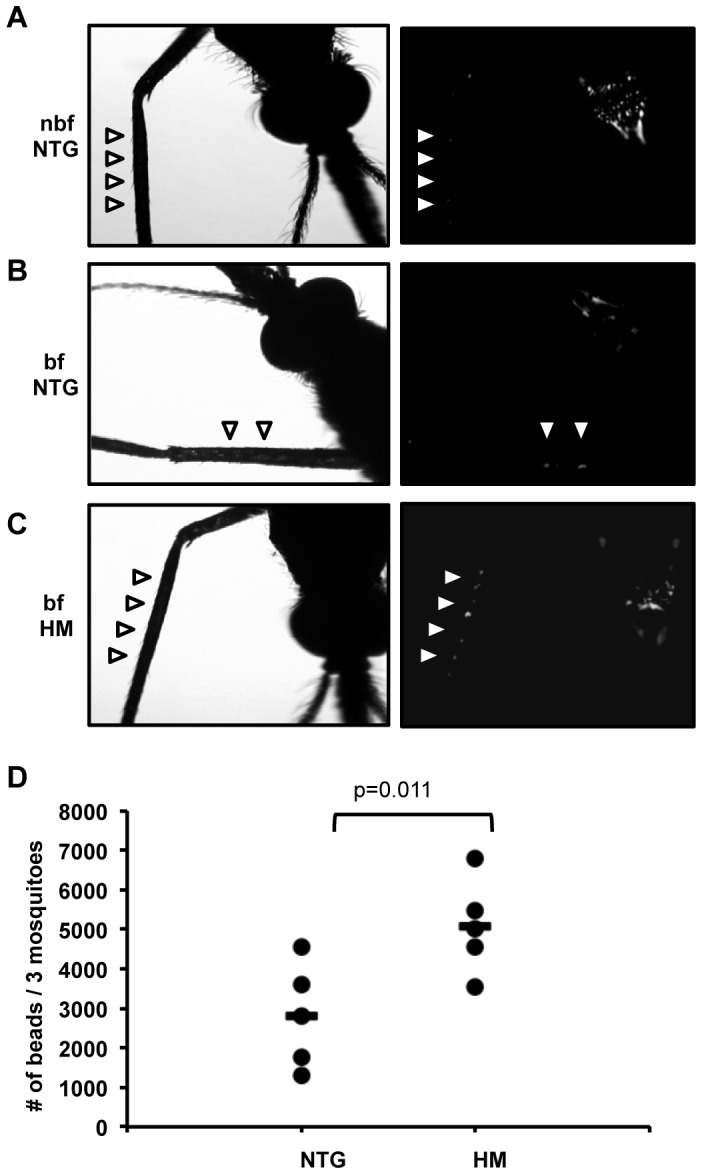
Evaluation of midgut permeability in HM myrAkt relative to NTG An. stephensi.(A) 3–5 d old, age-matched non-blood-fed NTG (nbf NTG), (B) blood-fed (bf) NTG and (C) HM female mosquitoes, were fed fluorescent beads (3–3.5 µM, Spherotech) in a reconstituted human blood meal through a Hemotek Insect Feeding System (Discovery Workshops). Prior to feeding (nbf NTG) and at 48 h post-blood feeding (bf NTG, bf HM), five whole mosquitoes from each group were cold-anesthetized and placed in 24-well plates. Mosquitoes were photographed under normal light (left panels) and also imaged on a Nikon TE 200 inverted fluorescent microscope at 4× with identical settings for all fluorescent images (right panels). Autofluorescence is visible on the mosquito thorax in all images. Arrowheads in nbf NTG mark location of mosquito leg and in bf NTG and bf HM images mark fluorescent beads in mosquito legs, an indication of bead passage through the midgut epithelium into the hemocoel. Note larger number of beads in bf HM compared to bf NTG An. stephensi. (D) Bead numbers per three whole mosquitoes minus bead numbers in three paired midguts from the same groups at 48 h post-feeding are represented as individual dots (means indicated as bars). Midgut beads averaged 236 for bf NTG and 225 for bf HM at 48 h post-feeding, so midgut beads accounted for less than 10% and less than 5%, respectively, of NTG and HM whole body bead counts. Data were analyzed by Student's t-test (alpha = 0.05).